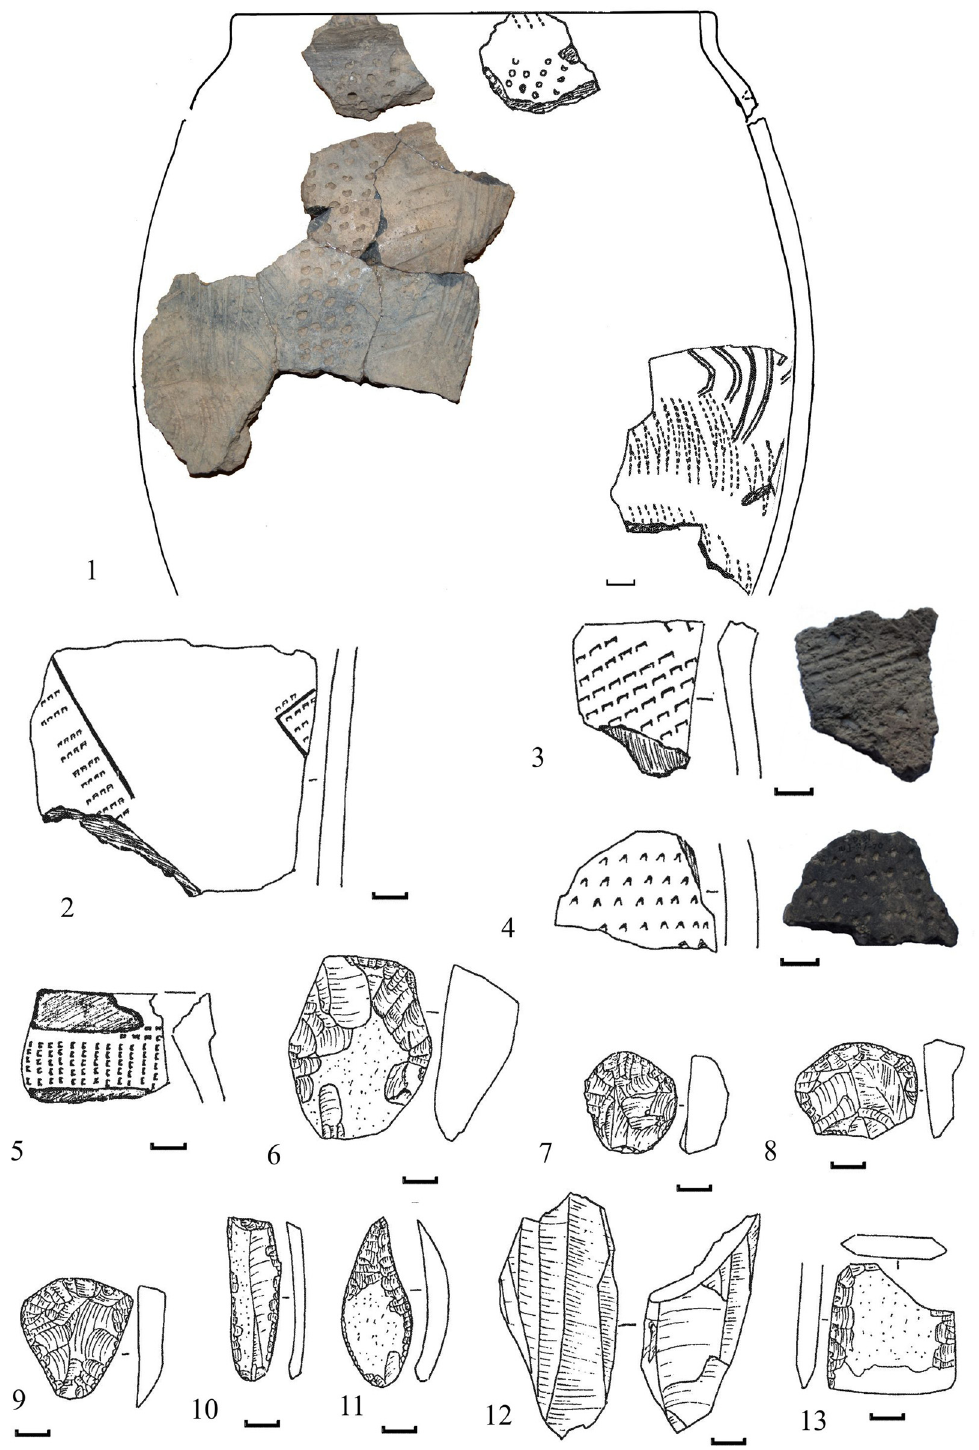
Figure 7: Finds from Razdolnoe ( 5360 – 5310 calBCE ) . 1 – 5 – potsherds; 6, 12 – knapped objects; 7 – 9 – end - scrapers; 10 retouched and truncated blade; 11 – point; 13 – adze - like